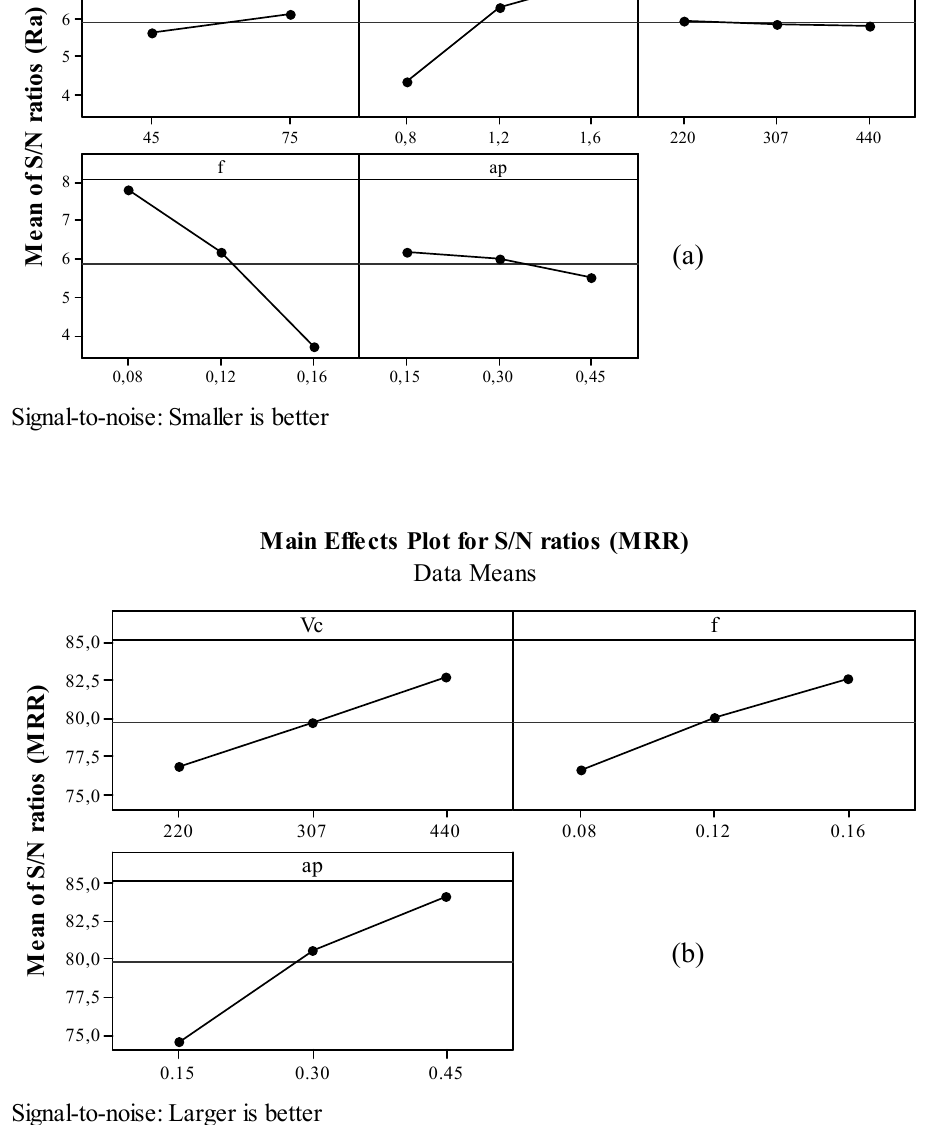
Fig. 5. Main effect’s plots of S/N for: (a) surface roughness, (b) material removal rate In order to check the influence of interaction of the depth of cut and the feed rate on the surface quality (S/N ratio for Ra), 3D response surface for the effect of the interaction is drawn in Fig. 6 (a). Variables not represented in the figure are held constant at the middle level ( χ r = 60°, r = 1.2 mm, Vc = 330 m / min). This figure indicates that, for a given depth of cut, the surface quality is sensitive to the feed rate because the increase of this latter deteriorates quickly the surface quality. This is consistent with the conclusion of research work published by Bouzid et al. (2015) where they remarked that the surface roughness ( Ra ) rapidly increases by increasing feed rate. However, this decrease in surface quality becomes increasingly small with lower values of the depth of